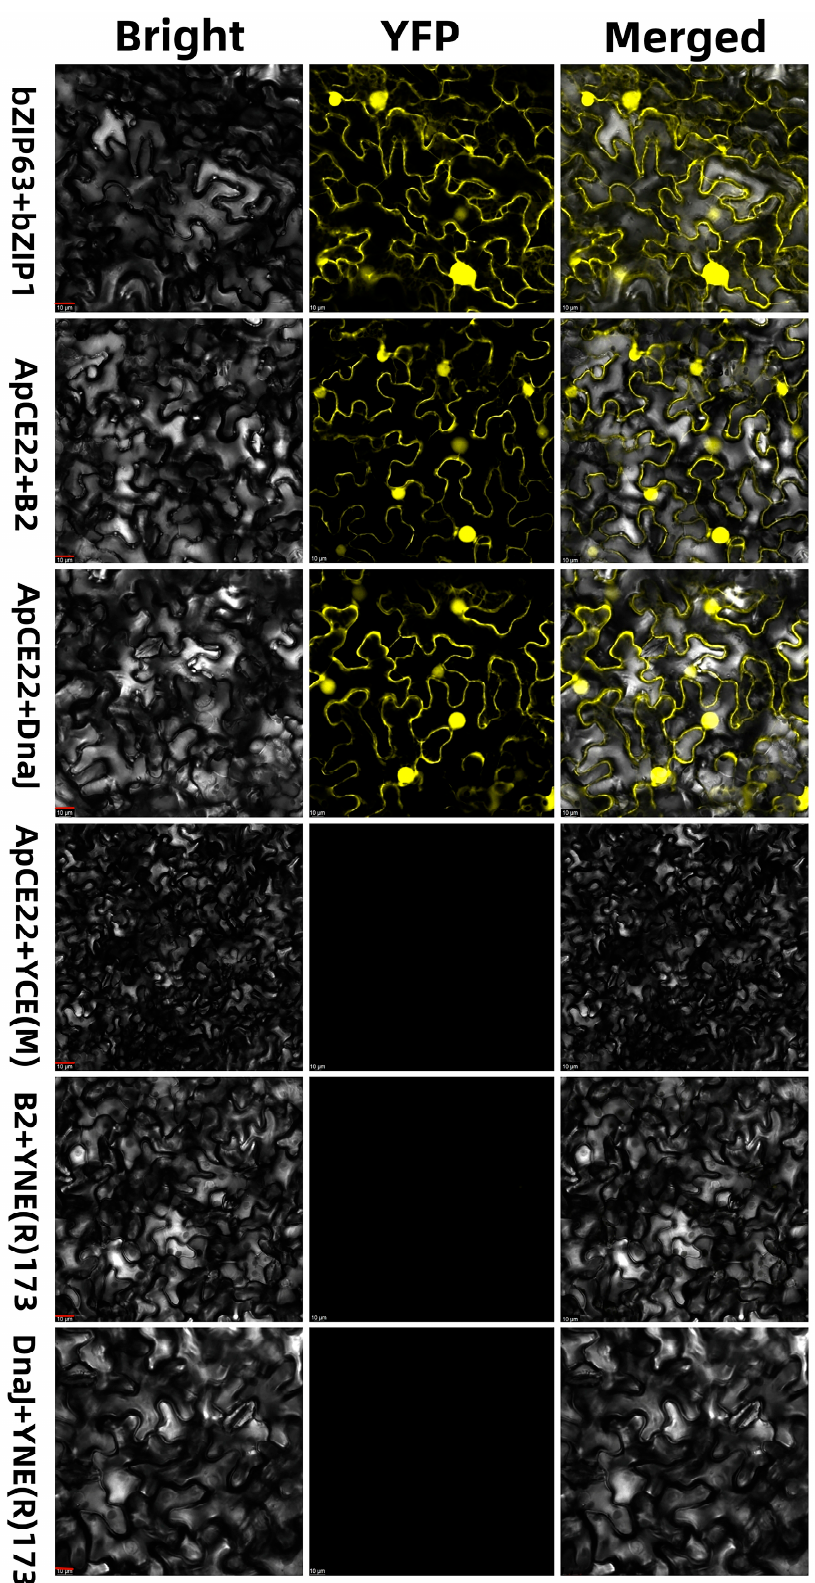
Figure 3. Results of the bimolecular fluorescence complementary reaction between the effector ApCE22 and the interaction proteins in tobacco. Note: The red bar indicates 10 μ m. Tobacco is a recognized substitute for verifying protein interactions in hybrid bamboos that have not yet successfully established a genetic transformation